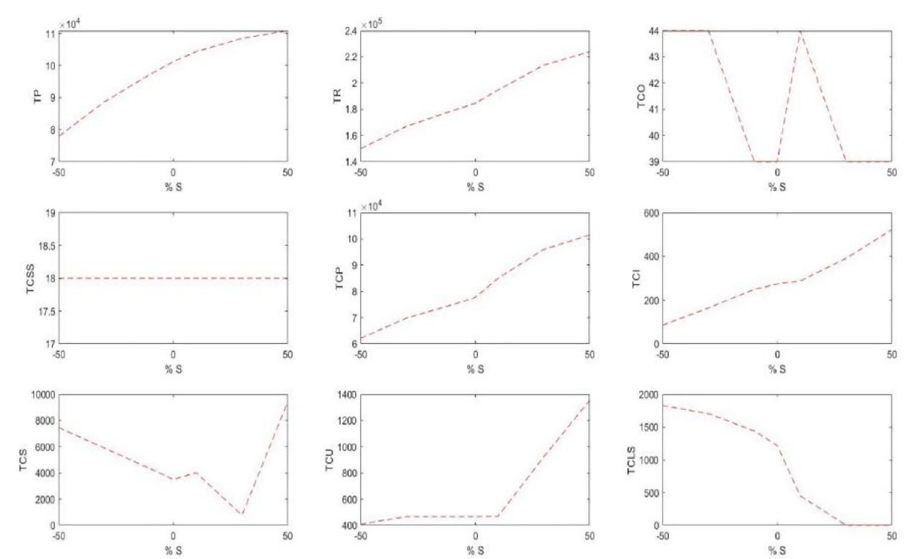
Fig 7. The trend of changes in the costs and sales profits due to the changes in the total shelf space.